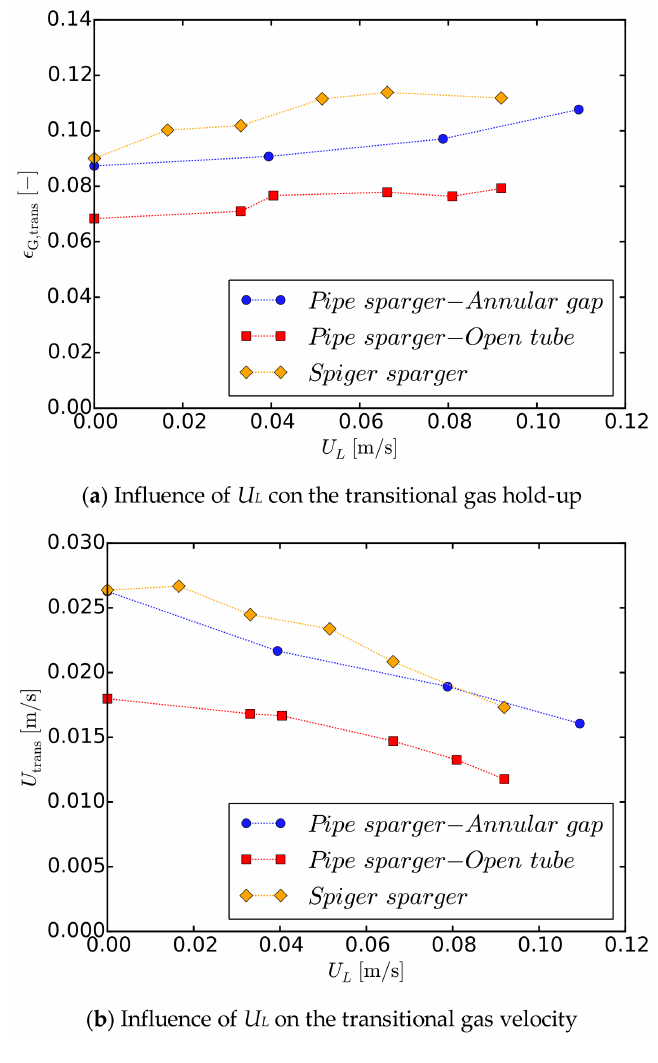
Figure 7. Influence of U L on flow regime transition points—data obtained by Besagni et al.